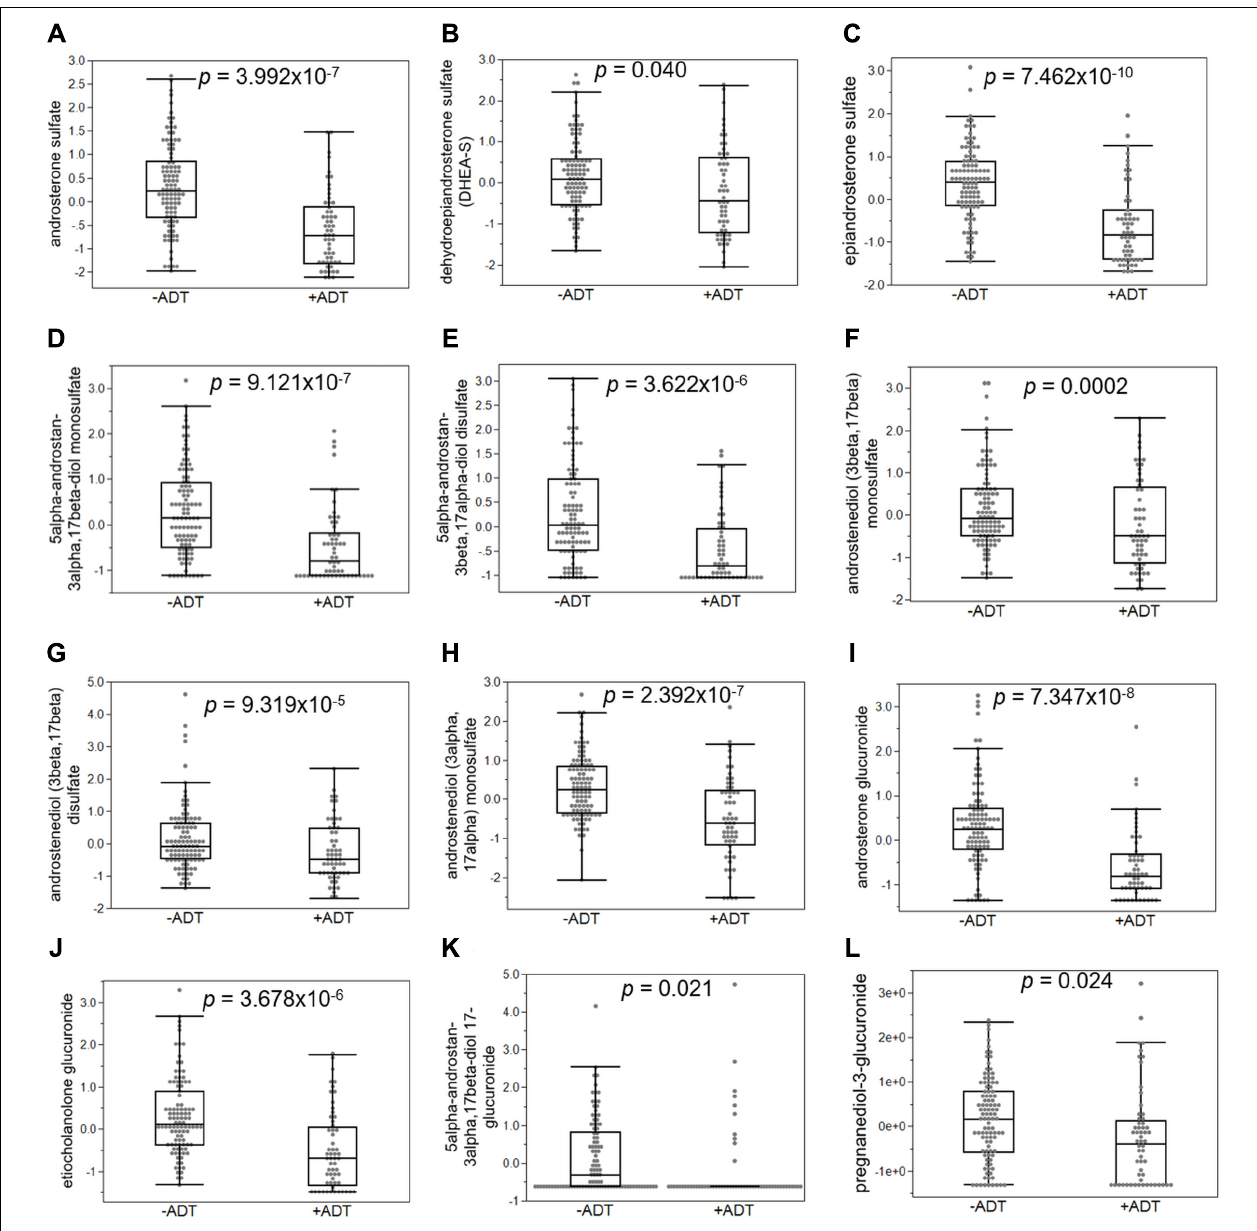
FIGURE 2 | Androgen deprivation therapy broadly affected metabolites related to steroid hormone biosynthesis. (A) Androsterone sulfate was significantly decreased in patients with ADT. Sulfated (B–H) and glucuronidated androgen metabolites (I–L) were significantly decreased in the +ADT group. * p < 0.05 and false-discovery rate ≤